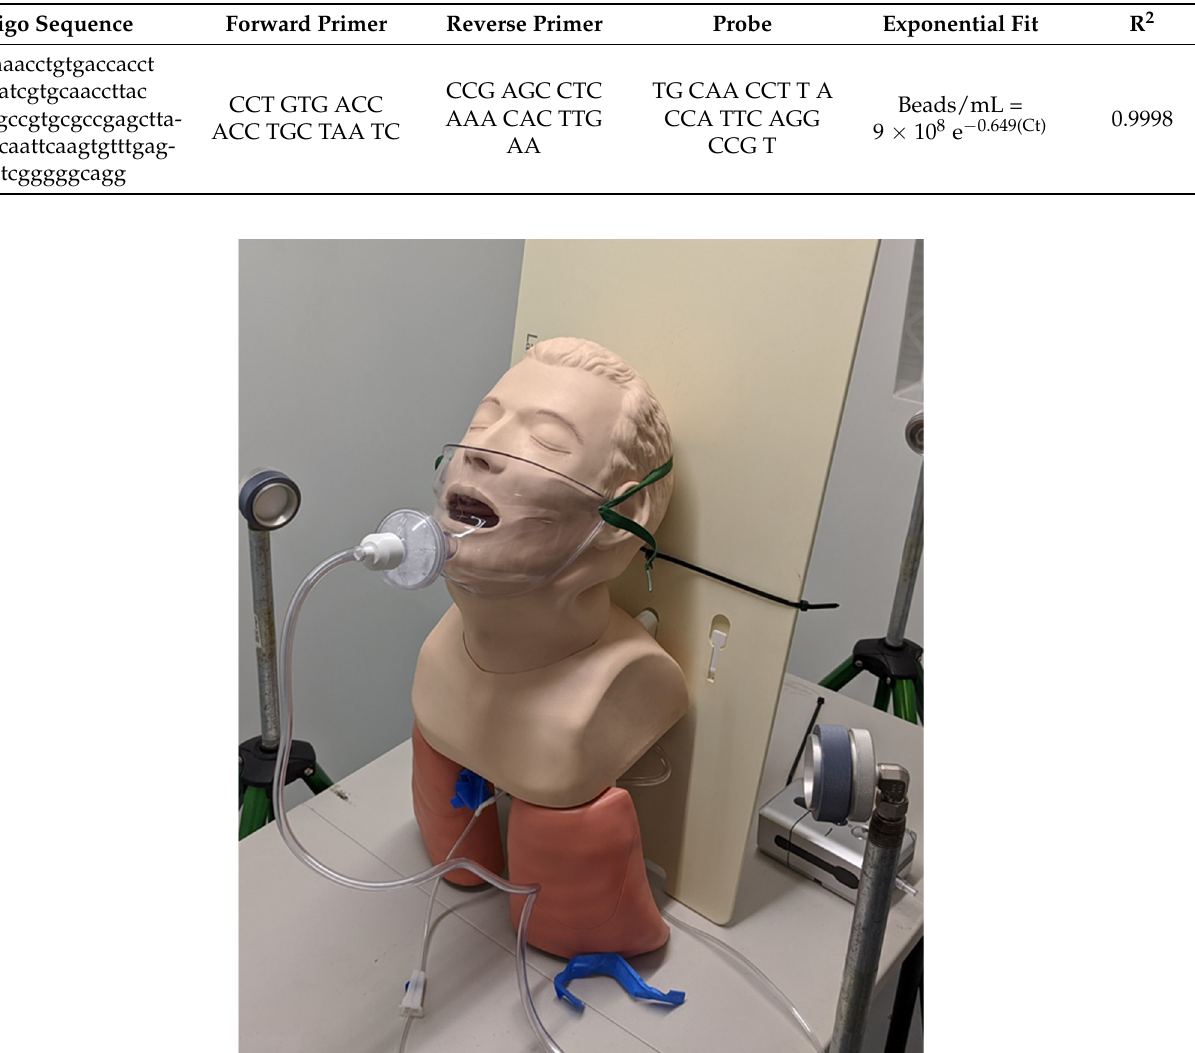
Table 1. Properties of DNA oligo attached to PSL